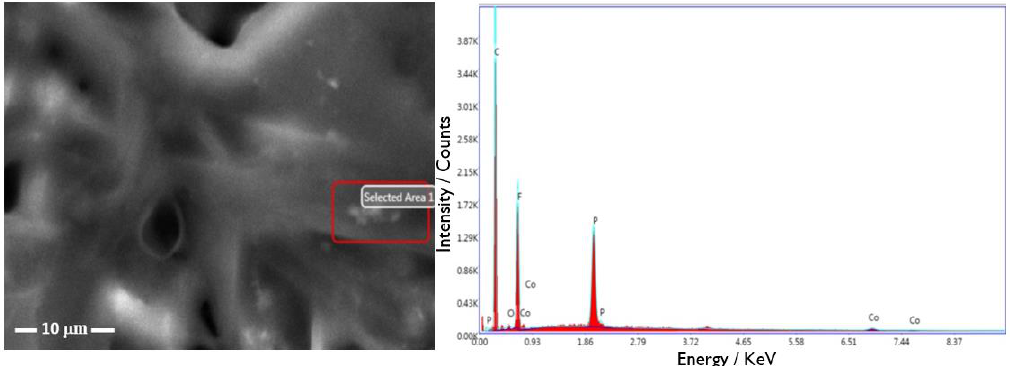
Figure 3. FESEM image and composition study by EDX for the system Gr/IL/Co. Magnification = 6525×.